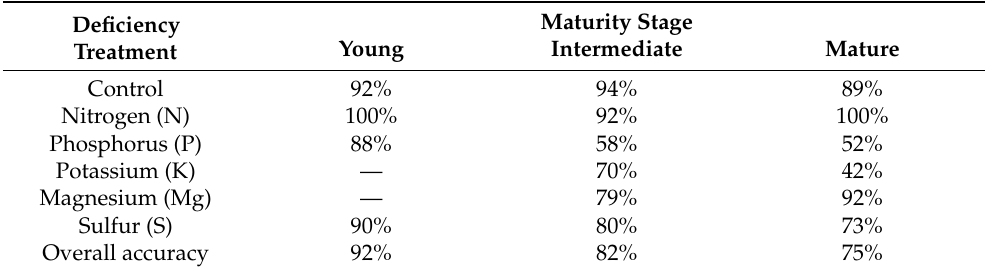
Table 3. Linear discriminant analysis classification accuracies for nutrient deficient flue-cured tobacco ( Nicotiana tabacum L.) plants based on principal component